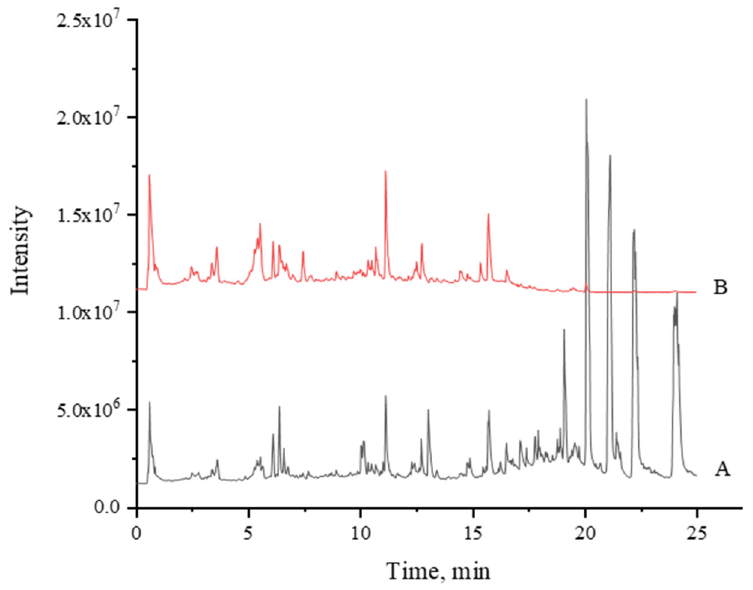
Figure 1. Total ion chromatogram of UPLC-MS of MBE. ( A ), Positive; ( B ), Negative. Table 1. Tentatively identified compounds from Jialing 20 ( Morus multicaulis ) mulberry branch by UPLC-ESI-MS/MS. No.